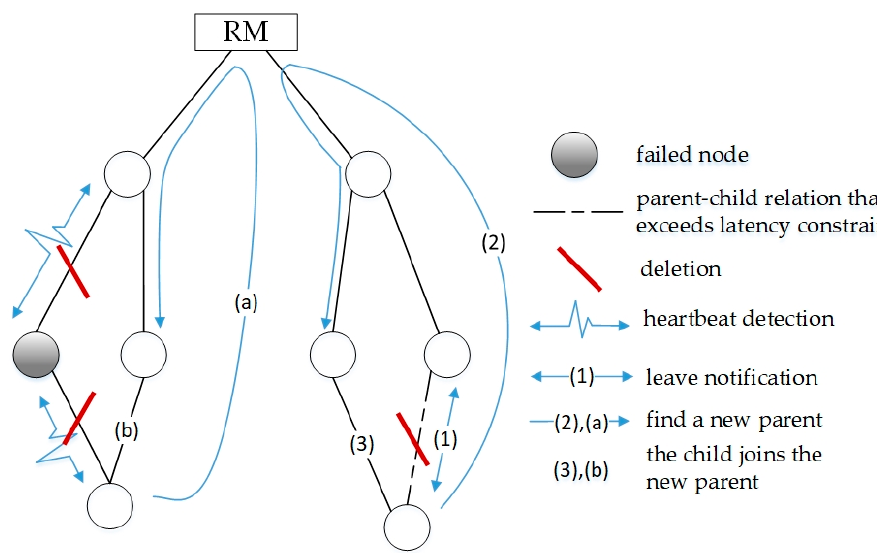
Figure 7. Example of node failure recovery .